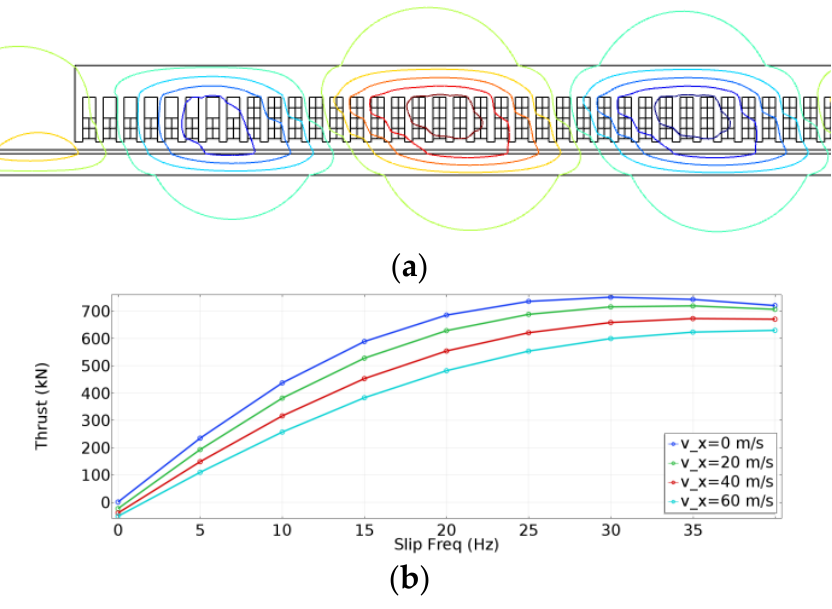
Figure 17. Magnetic field distribution within the end part of the SLIM ( a ). SLIM characteristics for different speeds ( b )